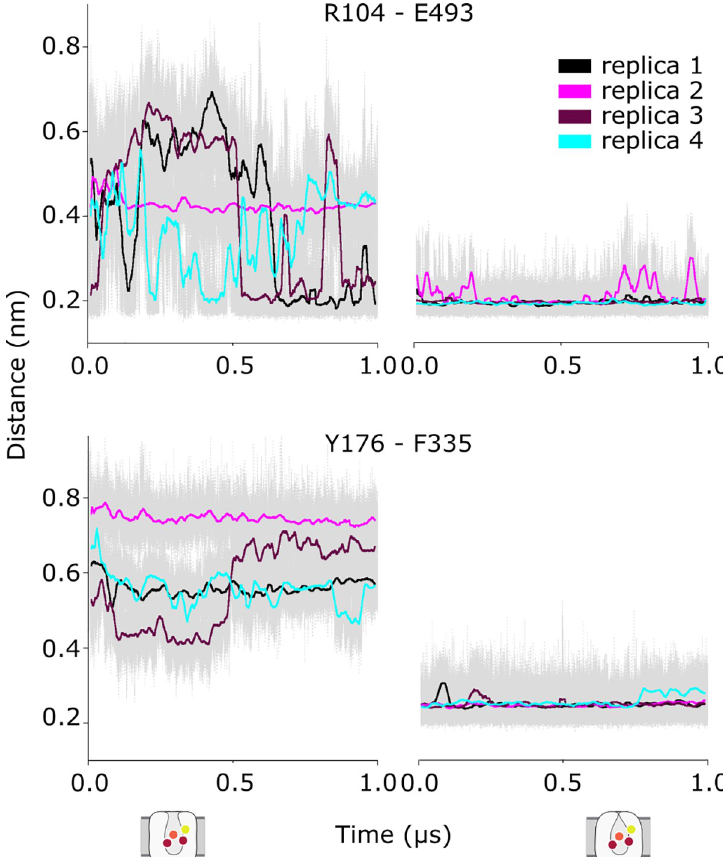
Fig 7. Behavior of the extracellular gates over time during molecular dynamics simulations of hSERT. The average minimum distances of the atoms between the R104-E493 and Y176-F335 gates are shown in 4 different trajectories for the outward-open (left) and outward-occluded states (right), with standard errors shown in the back (gray).